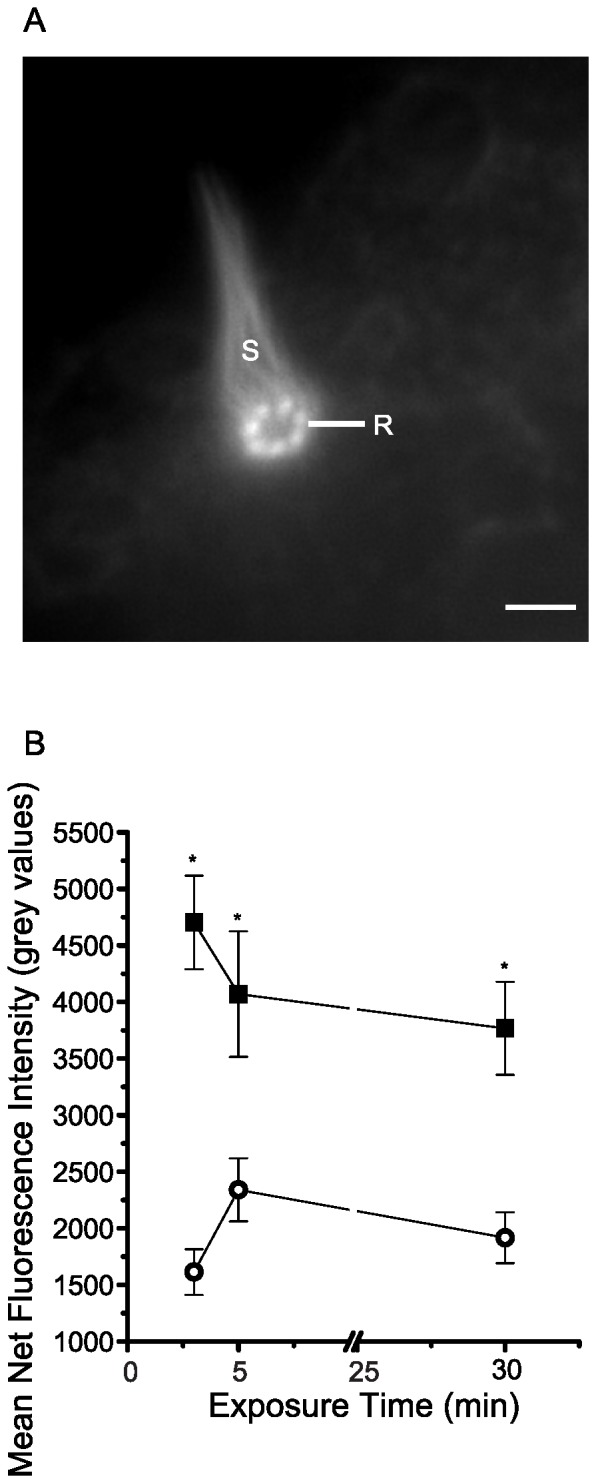
F-actin cytochemistry and effects of the CDH23 peptide on rhodamine-phalloidin fluorescence intensity of hair bundles.(A) Rhodamine-phalloidin labeled stereocilia (S) and rootlets (R) of hair bundles in N. vectensis. Scale bars  = 2 µm. (B) Untreated controls (closed squares) and specimens incubated in 10 nM CDH23 peptide (open circles) were fixed and then incubated in a rhodamine conjugate of phalloidin. Mean fluorescence intensity was obtained from analysis of digital images of hair bundles. Background fluorescence was subtracted to yield net fluorescence intensity. Mean net fluorescence intensity is plotted (±SEM, n = 3) in grey values. Asterisks indicate significant differences between mean net fluorescence intensity of untreated controls and specimens exposed to 10 nM CDH23 peptide (p<0.05).